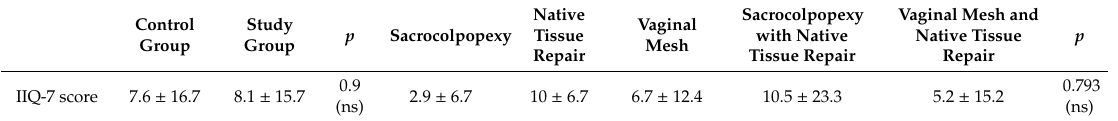
Table 6. The results of the IIQ-7 questionnaire in both groups 6–12 months after TVT sling implantation, with regard to the type of reconstructive surgery.